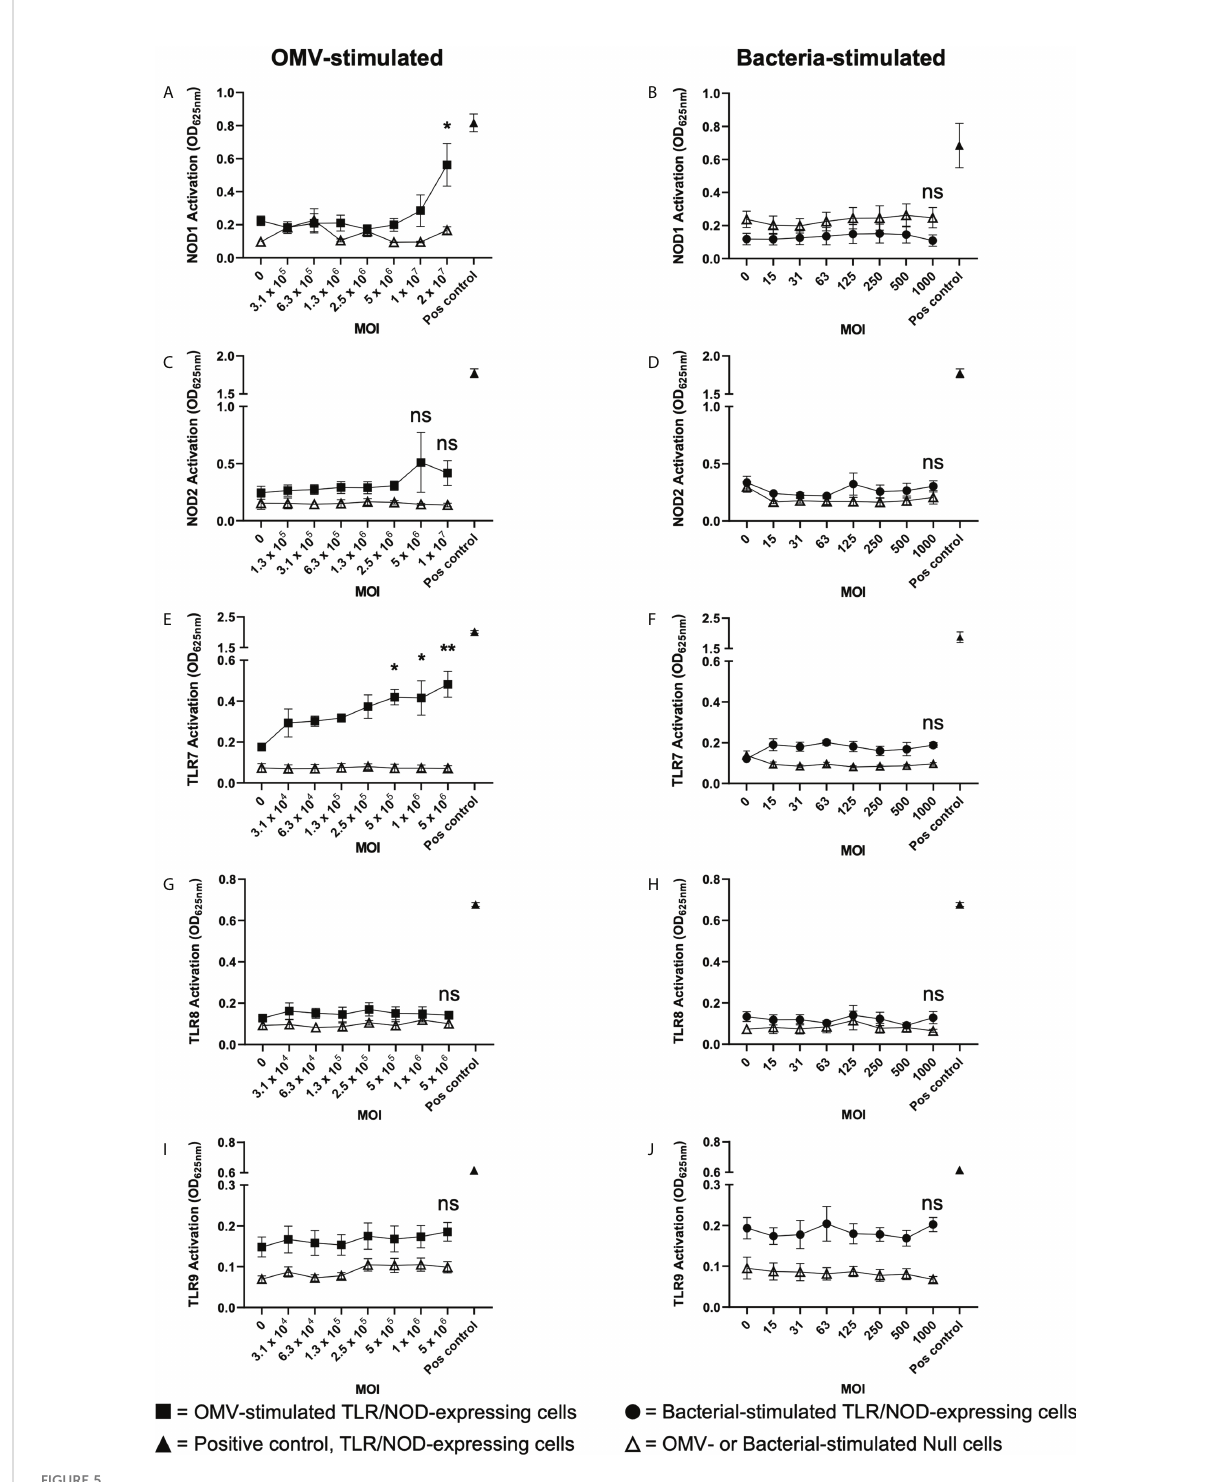
FIGURE 5 B fragilis OMVs activate NOD1 and TLR7 whereas B fragilis bacteria cannot. (A, B) NOD1, (C, D) NOD2, (E, F) TLR7, (G, H) TLR8 and (I, J) TLR9 expressing HEK-Blue cells were stimulated with an increasing MOI of either B. fragilis OMVs ( A , C , E , G , I , squares) or B. fragilis bacteria ( B , D , F , H , J , circles) for 18 hours. Open triangles indicate stimulation of the HEK-Blue null cell line with either B. fragilis OMVs or B. fragilis bacteria as a negative control in each assay. Filled triangles indicate positive controls for each respective cell line. Data represents mean ± SEM of three biological replicates. ns=not signi fi cant, *p < 0.05, **p < 0.01. (One-way ANOVA with Dunnett ’ s multiple comparisons test, compared to non- stimulated